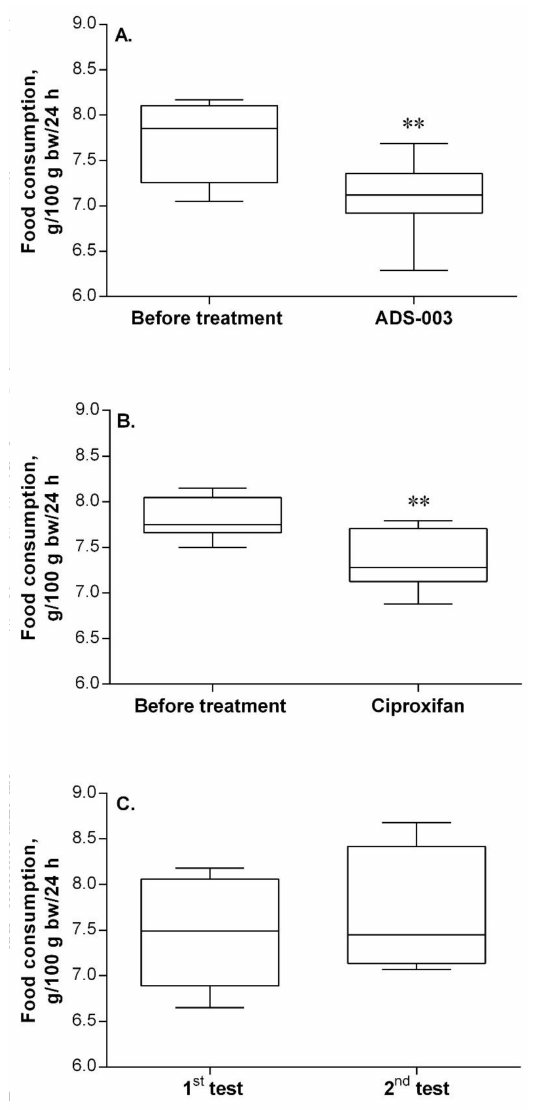
Figure 2. The effect of ADS-003 (s.c. 3 mg/kg/daily for 5 days), the newly synthesized histamine H 3 receptor antagonist ( A ), and of the reference compound Ciproxifan (s.c. 3 mg/kg/daily for 5 days; B ) on food intake. Consumption by untreated rats ( C ). The median (the line in the middle of the box) and the range of values (whiskers) are given for eight rats. Paired t -test: ** p < 0.01 versus before